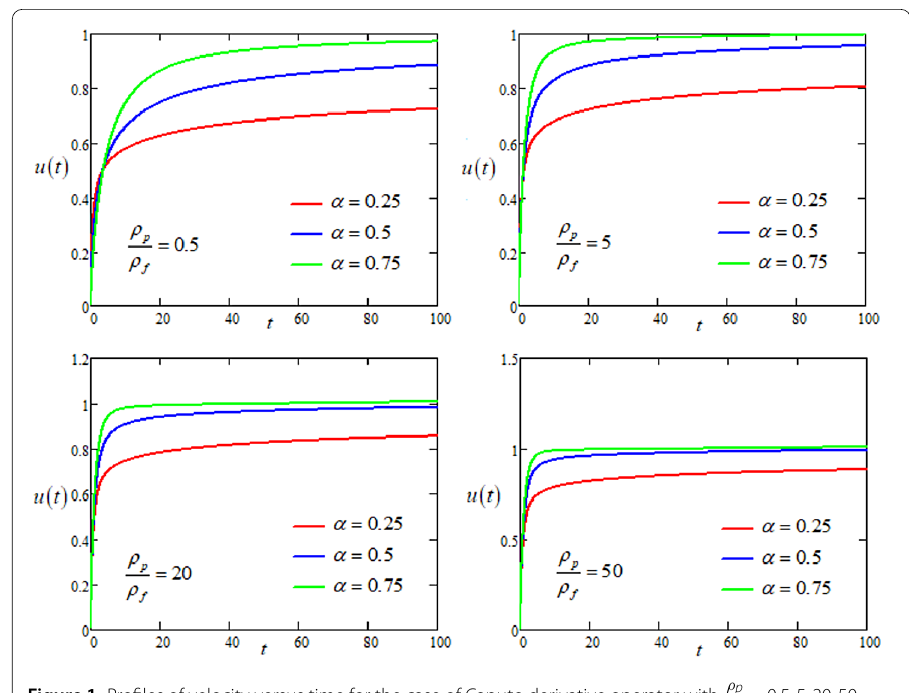
Figure 1 Profiles of velocity versus time for the case of Caputo derivative operator with ρ p ρ